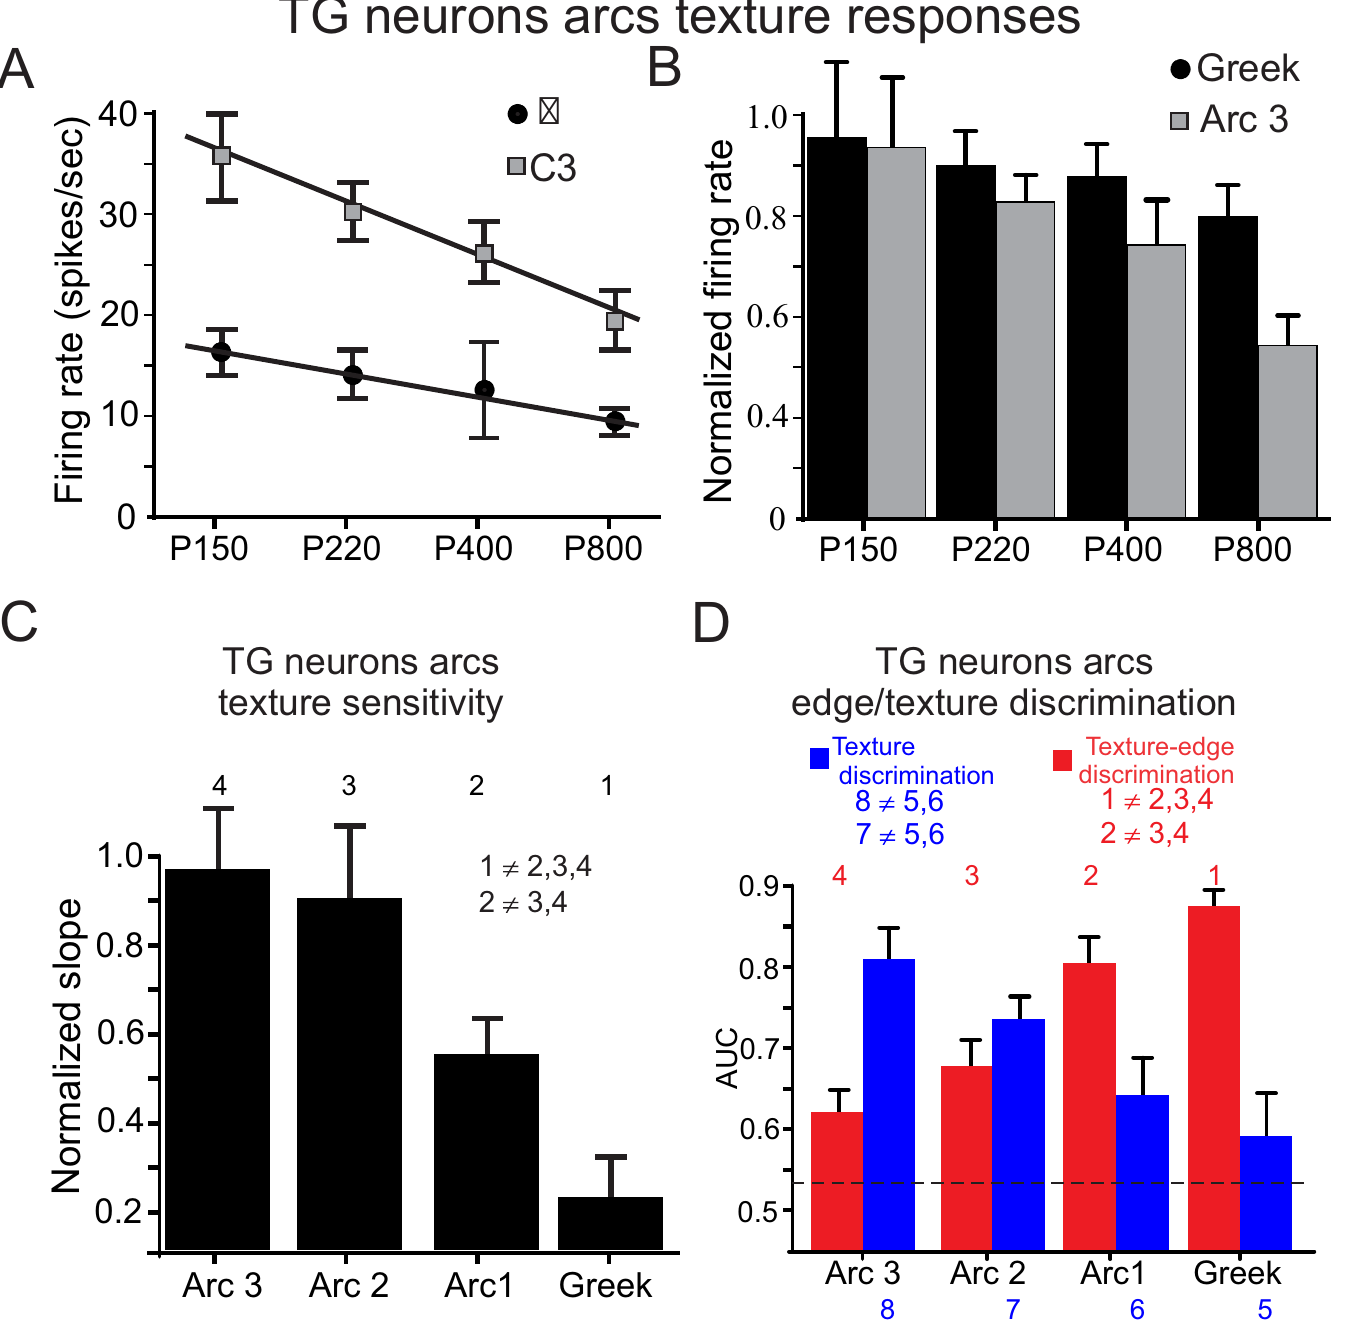
Fig 7. TG neurons innervating rostral whiskers exhibit higher response sensitivity to texture grain. (A) The relationship between texture coarseness and TG firing rates in 2 arcs. (B) Normalized firing rates (normalized to the maximal firing rates) for all neurons innervating Greek and arc 3 whiskers in response to the different textures. (C) Normalized slopes of the linear regression fit for normalized firing rates versus texture surface coarseness. (D) AUC for texture discrimination (blue bars) and texture-edge discrimination (red bars) for the different arcs. The numbers indicate the different arcs. The inequality sign indicates a statistically significant difference between the various arcs. The underlying data for this Figure can be found in S1 Data. AUC, area under the receiver operating characteristic curve; TG, trigeminal